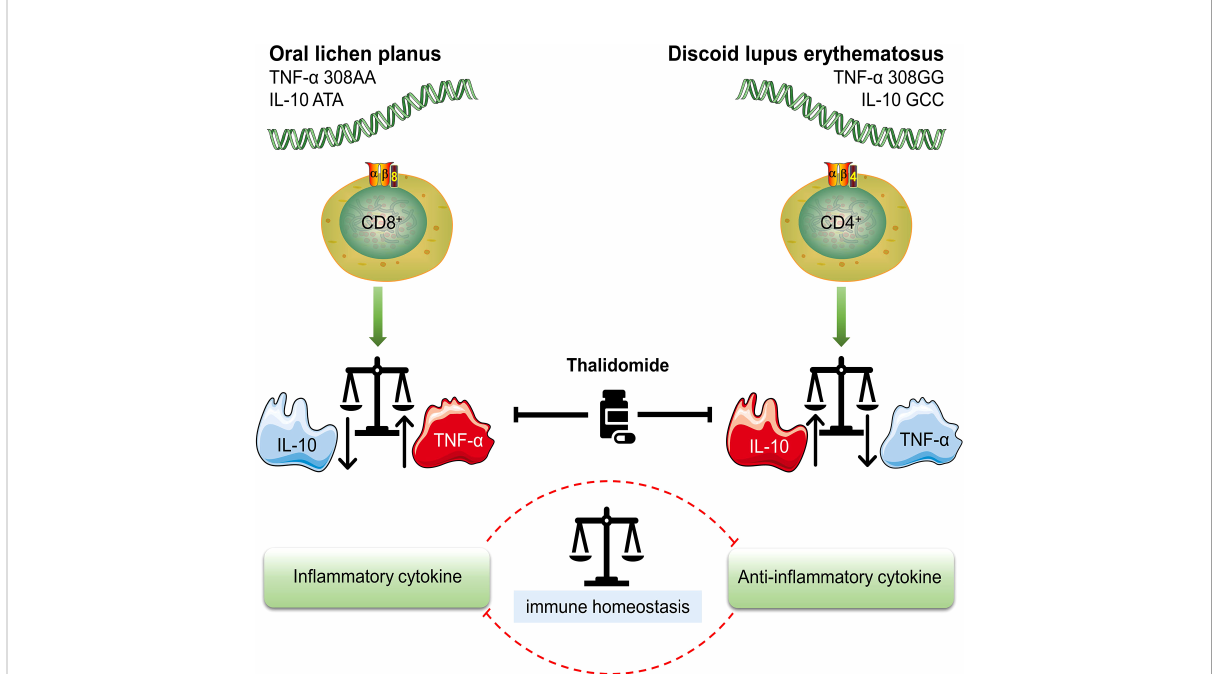
FIGURE 1 Different genotypes of OLP (oral lichen planus) and DLE (discoid lupus erythematosus) High TNF- a (TNF- a 308AA)/low IL-10 (IL-10 ATA) genotype is characterized by a higher production of TNF- a and is more likely to result in OLP. TNF- a is mainly secreted by CD8+ cytotoxic T cells, which are also the most OLP-associated T cells. High IL-10 (IL-10 GCC)/low TNF- a (TNF- a 308GG) genotype suggests increased risk and prevalence of DLE. The overexpression of IL-10 is associated with the enrichment of CD4+ T cell subsets. Treg (regulatory T cell) and Th1 (T helper 1 cell), two typical CD4+ T cell subsets, are sources of IL-10 in DLE. Either an increase or decrease in TNF- a and IL-10 leads to an imbalance in the immune system, which ultimately initiates the onset of disease. Thalidomide is a multi-targeted IMiD (immunomodulatory drug) that inhibits both TNF- a and IL-10. The inhibition of IL-10 may be the underlying pharmacological mechanism in the treatment of